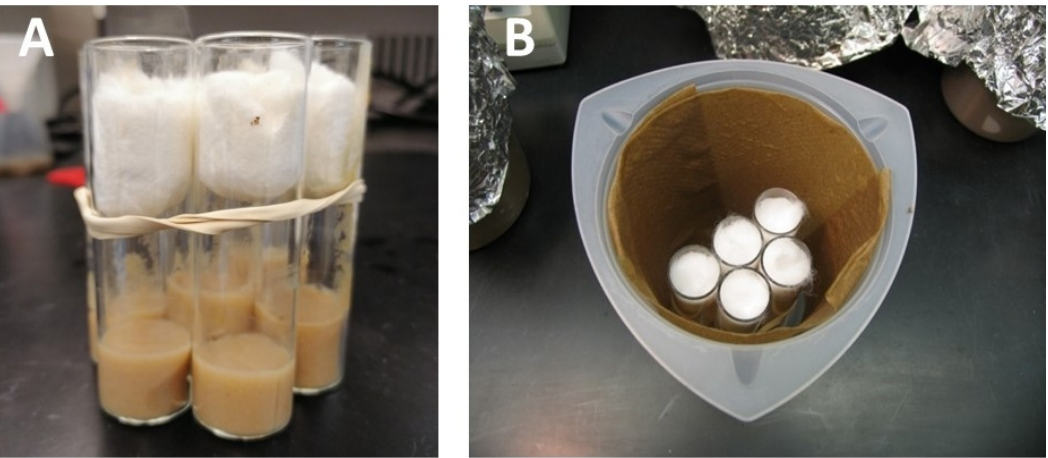
Figure 6. ( A ) Vials are bundled together with a rubber band. ( B ) A wet chamber for the vials containing injected eggs.